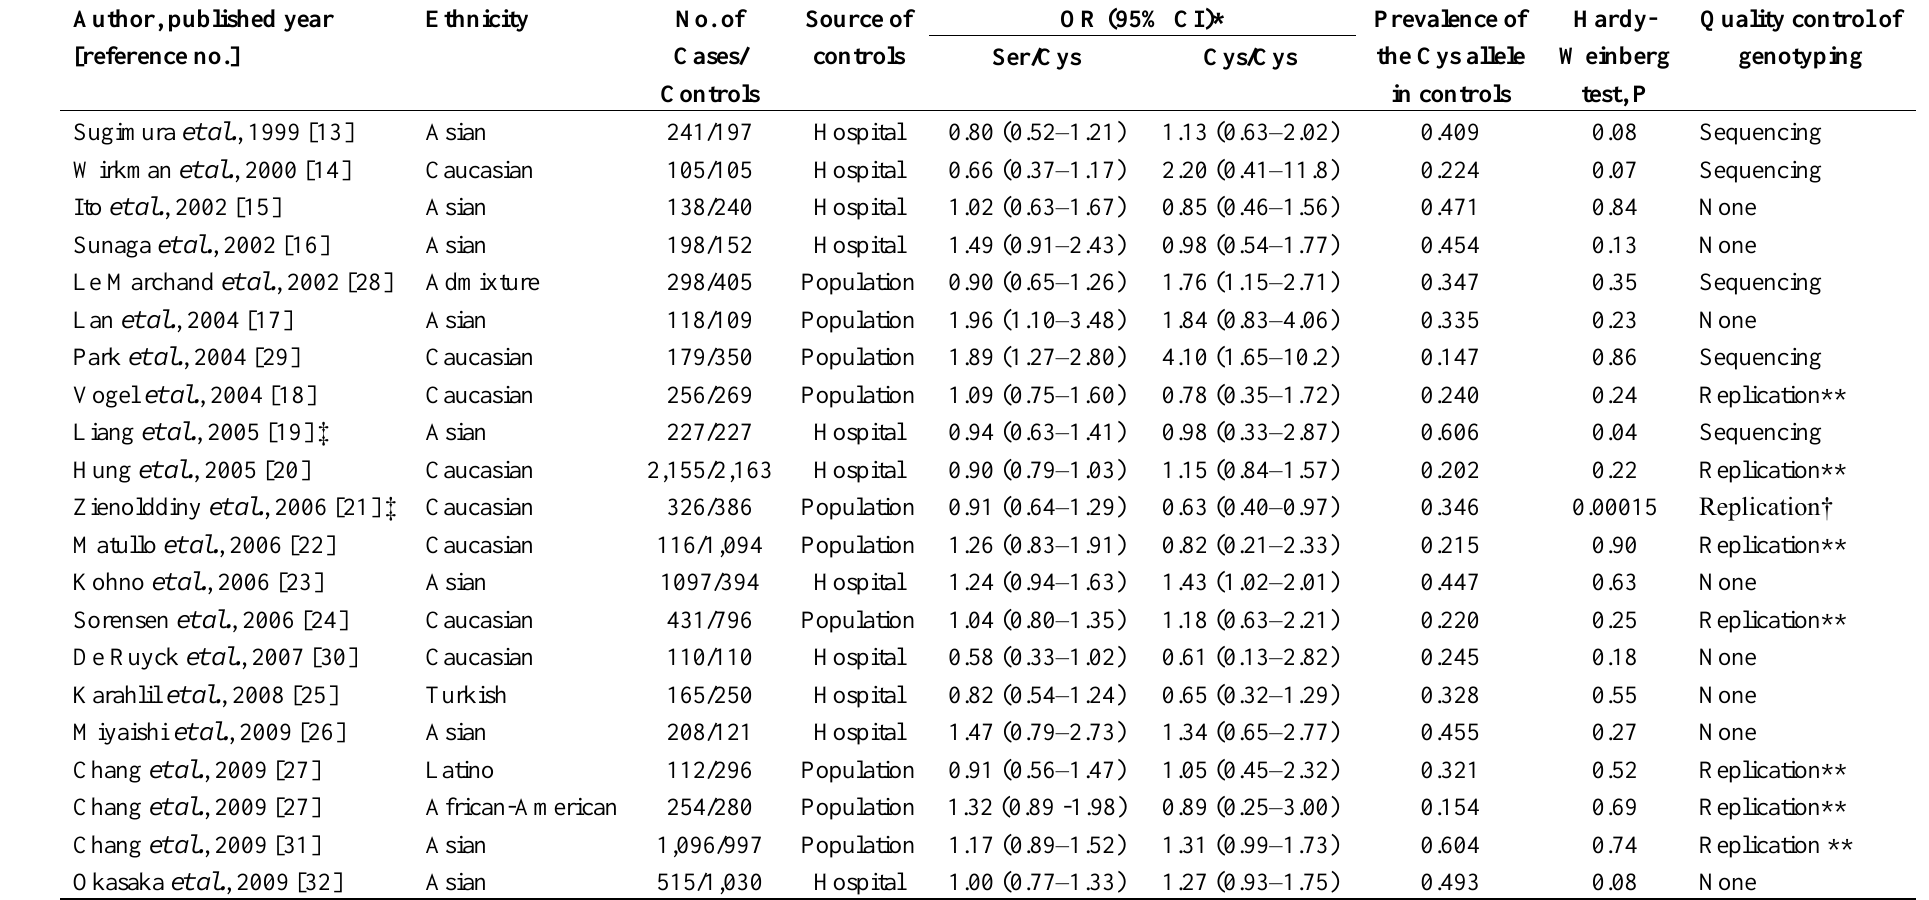
Table 1. Description of the studies included in the meta-analyses of the association between the hOGG1 Ser326Cys polymorphism and lung